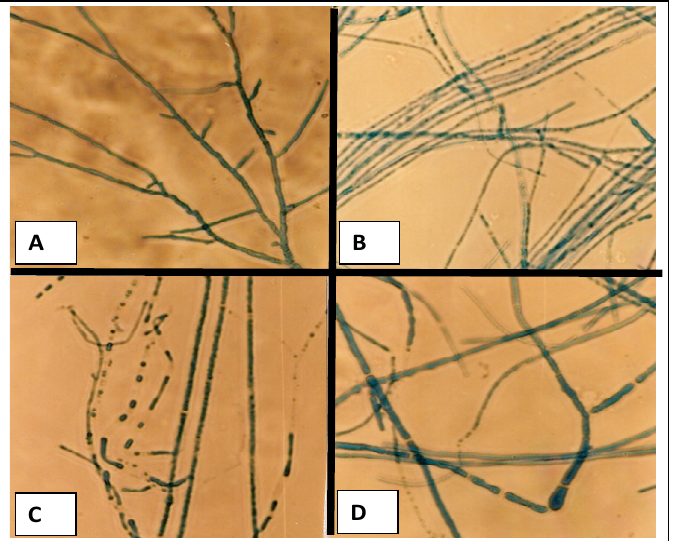
Figure 3. Morphological behavior of Trichoderma harzianum . A. Control culture; B. Culture treated with 1 mM of cadmium, C. Culture treated with 2 mM of cadmium and D. Culture treated with 3 mM of cadmium.